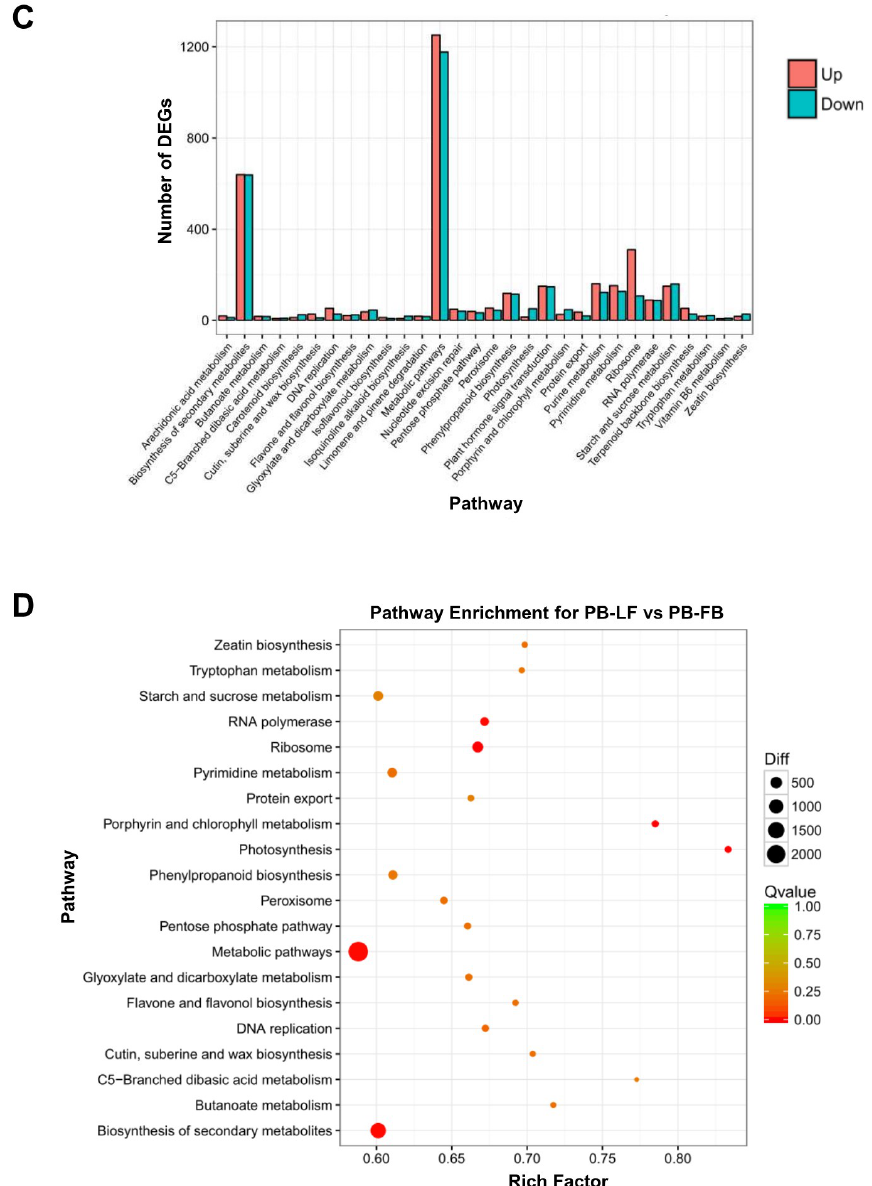
Figure 1. Statistics of all comparison among differentially expressed genes (DEGs) in GO and KEGG enrichment analysis. ( A ) Volcan plot for the distribution of DEGs. The differences in expression between PH-FB (developing floral buds) and PH-LF (mature leaves) were analyzed by using the FDR ≤ 0.001 and a fold change (the ratio of PH-FB/ PH-LF, log2) ≥ 2 as the criteria to screen DEGs. Each dot represents a unigene, and red and blue dots indicate DEGs that are up- and down- regulated, respectively. The green dots represent unigenes with no DEGs changes in these two samples. ( B ) Histogram of the DEGs number (up and down) in the enriched GO terms. These GO terms were classified into Biological Process, Cellular Component, and Molecular Function groups. ( C ) Histogram of the DEGs number (up and down) in the most enriched pathways. The most enriched pathways (30 terms) were selected, and statistics according to the up- and down- regulation of DEGs were compared with the controls. ( D ) The scatter plot from the results of DEGs enriched pathways. The Y-axis shows the top 20 enriched KEGG pathways. These 20 pathways were sorted with the increasing significant level from the bottom to the top on the Y-axis. The X-axis indicates the enrichment factor (the enriched gene number is proportional to the background gene number) for each enriched pathway. The larger points correspond to more DEGs numbers and the different colors of points show the different Q values.